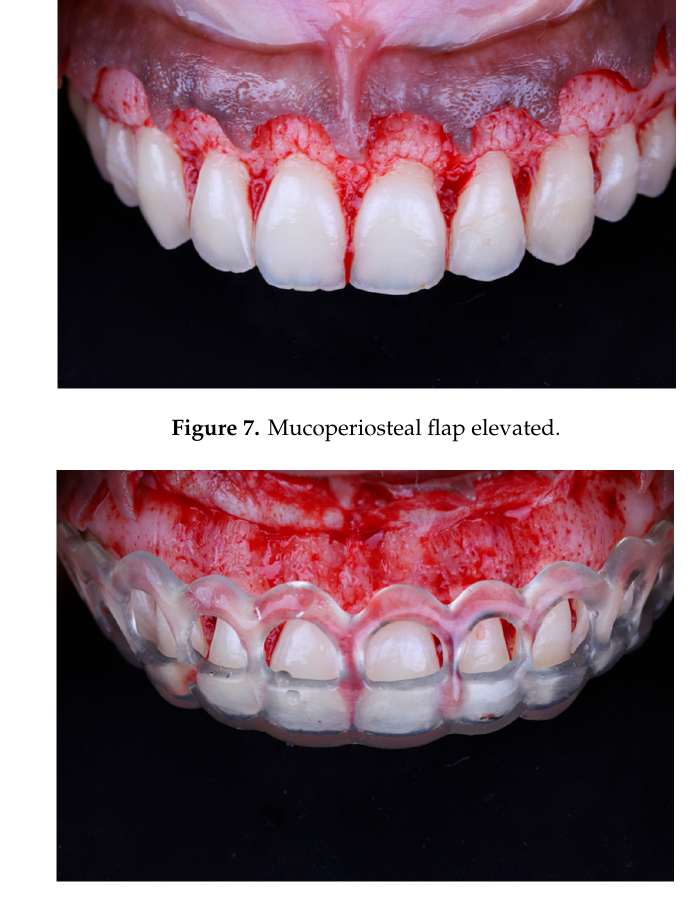
Figure 8. Surgical guide placed to determine level of osteoectomy.